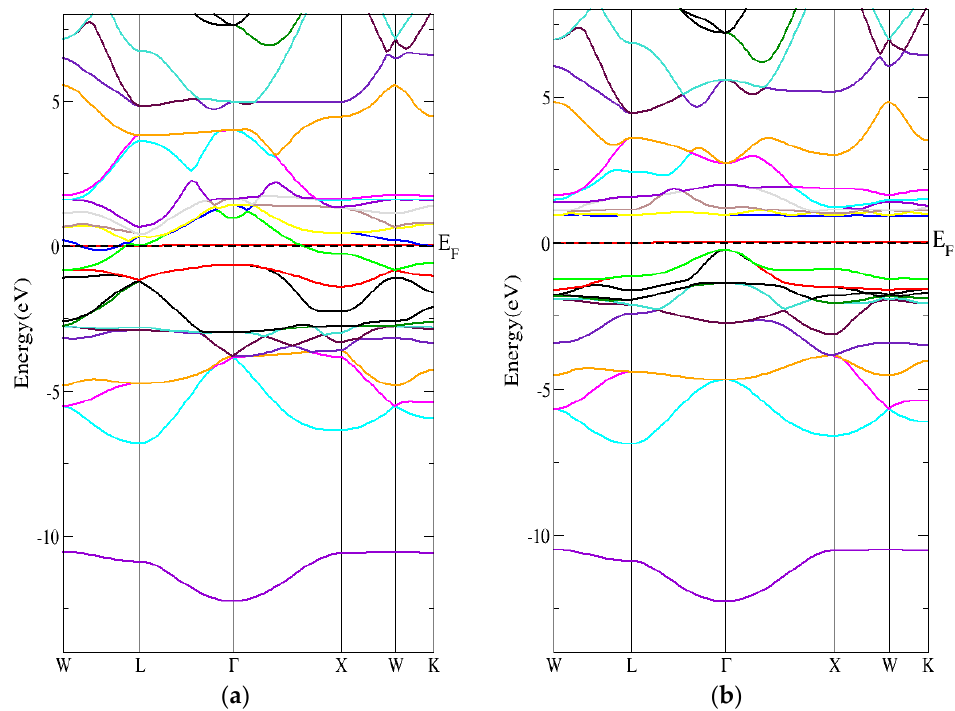
Figure 11. The band structure for the conventional Heusler Cr (cid:2870) MnSb compound by employing the mBJ–GGA technique for ( a ) spin-up conventional Heusler Cr (cid:2870) MnSb compound and ( b ) spin-down conventional Heusler Cr (cid:2870) MnSb compound.